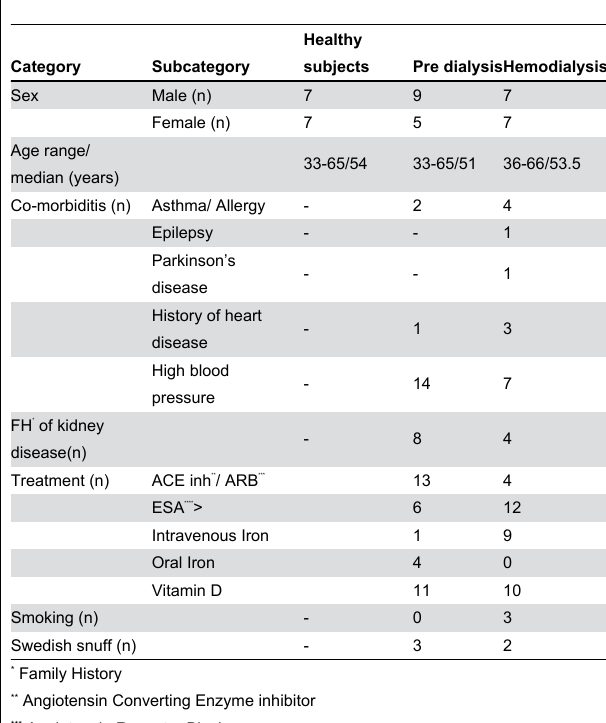
Table 1. Demographic characteristics of